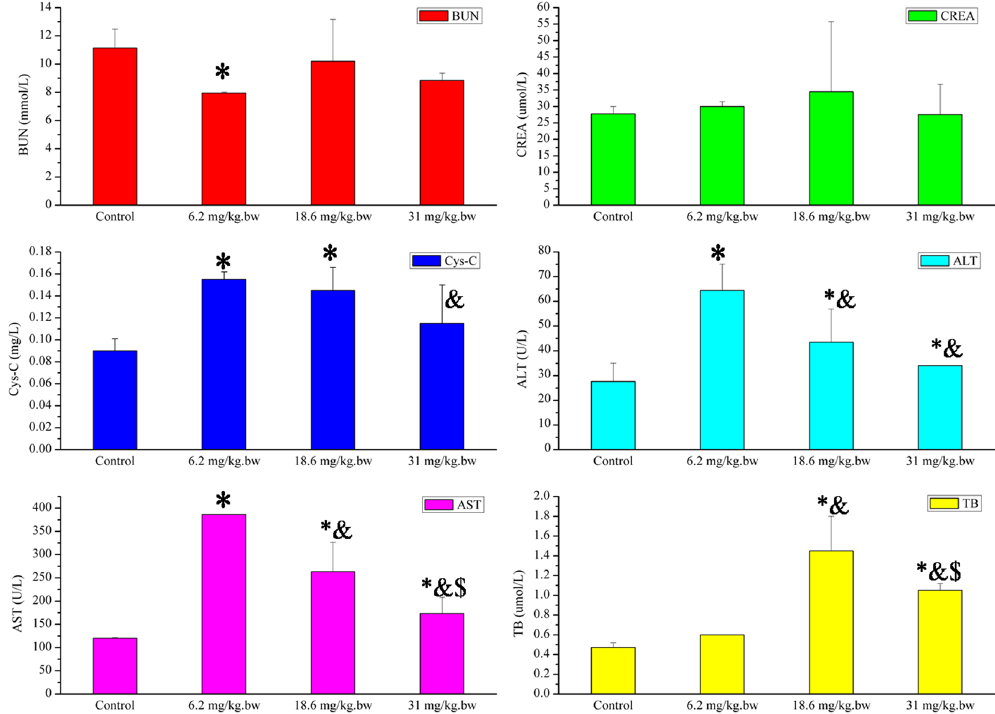
Figure 3. The biochemical indices level of BUN (blood urea nitrogen), CREA (creatinine), AST (aspartate aminotransferase), Cys-C (cystatin C), ALT (alanine aminotransferase) and TB (total bilirubin) change in plasma after exposure different dosages of 6.2, 18.6, 31 mg/kg.bw oMWCNTs to mice ( * p < 0.05 for groups vs . control group; & p < 0.05 for groups vs. 6.2 mg/kg.bw-group; $ p < 0.05 for groups vs. 12.4 mg/kg.bw-group; n = 5, +